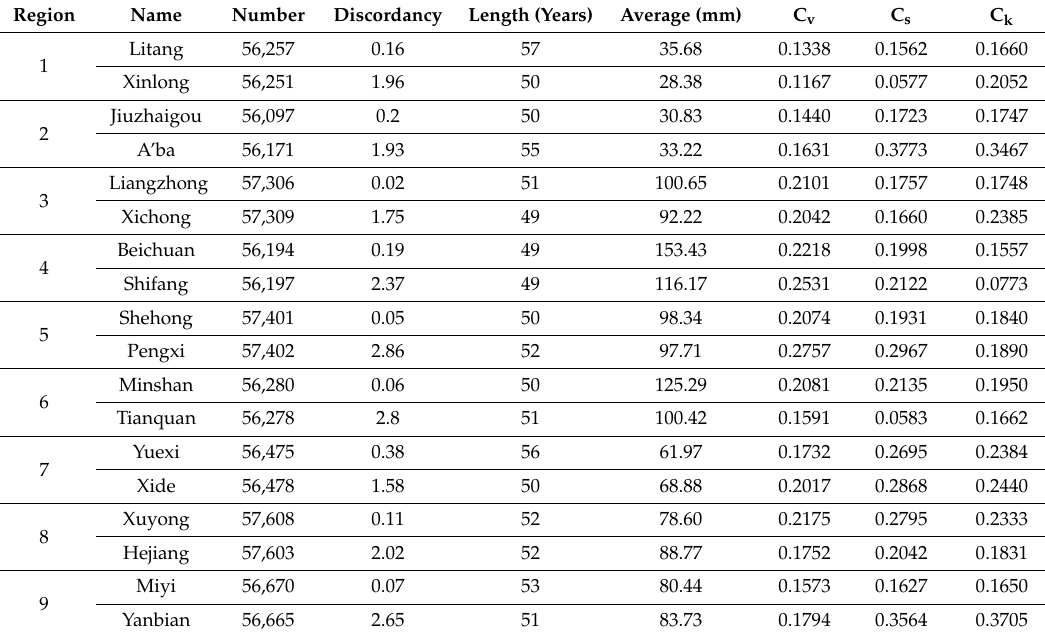
Figure 1. Schematic diagram of the study area and the selected representative meteorological site map. Table 1. Basic information of the selected representative